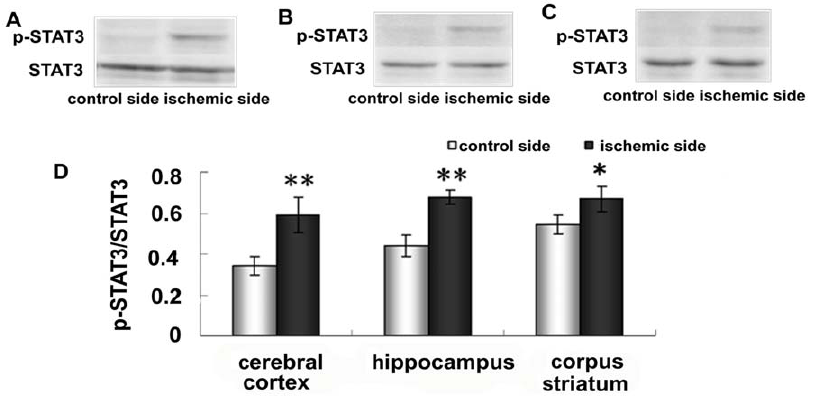
Figure 7. Expression of STAT3 in ischemic brain. Rats were subjected to 60 min MCAO and 24 hour reperfusion. Expression of STAT3 in cerebral cortex (A), hippocampus (B) and corpus striatum (C) was analyzed by Western blotting. D, summary of STAT3 expression in cerebral cortex hippocampus, and corpus striatum of contralateral and ipsilateral side. Results are presented as Mean 6 SEM, n=3. **p , 0.01 v.s. contraleteral side, *p , 0.05 v.s. contralateral side.